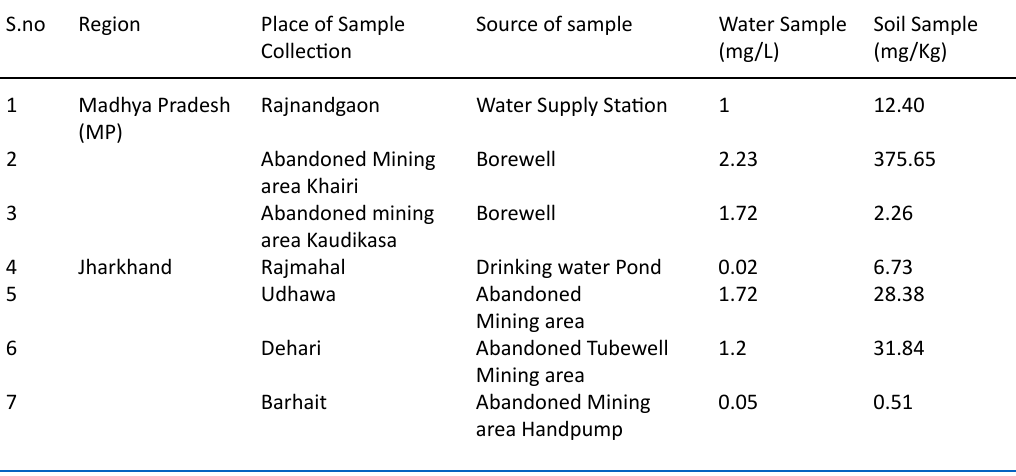
Table 1. Arsenic concentration in collected water and soil samples – ICPOES (inductively coupled plasma atomic emission spectroscopy)